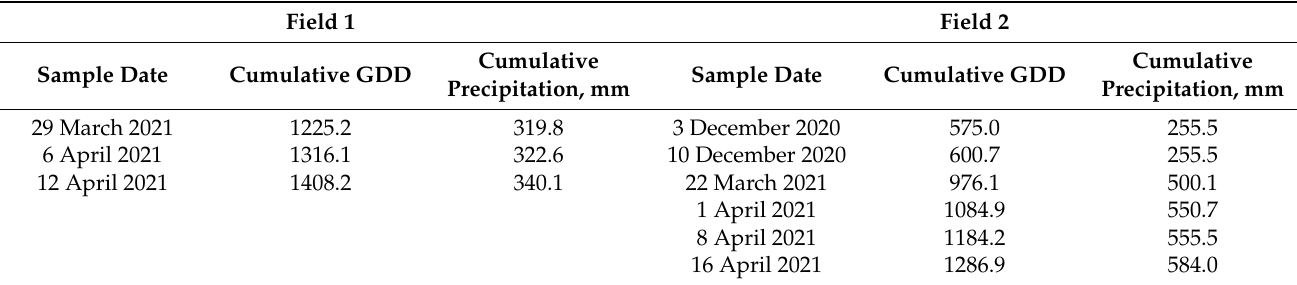
Table 2. The sample dates, accumulated growing degree days (GDD), and accumulated precipitation for field 1 and field 2.